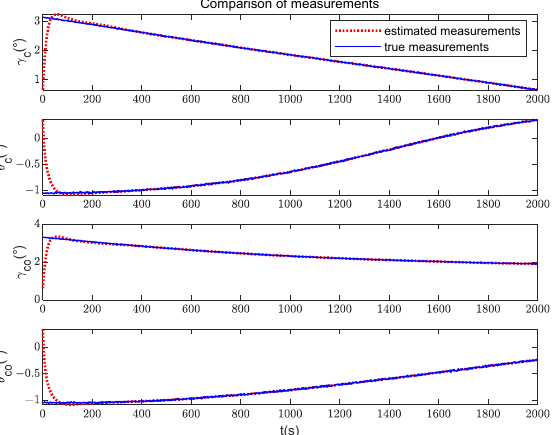
Figure 14. Comparison between the estimated measurements and true measurements.